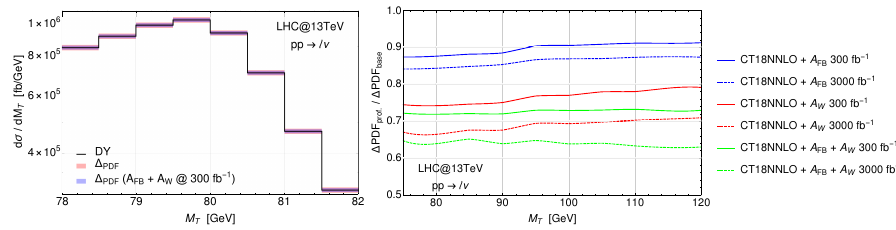
Figure 3: (left) Charged-current DY transverse mass distribution with PDF error; (right) relative improvement of PDF error on the transverse mass spectrum due to profiling based on A , A and their FB W